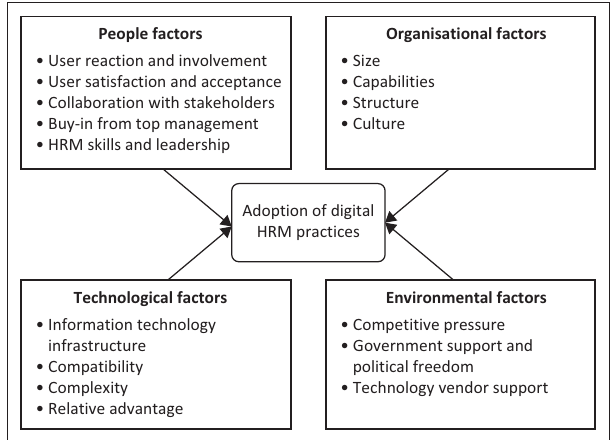
FIGURE 1: Challenges in adopting digital human resource management